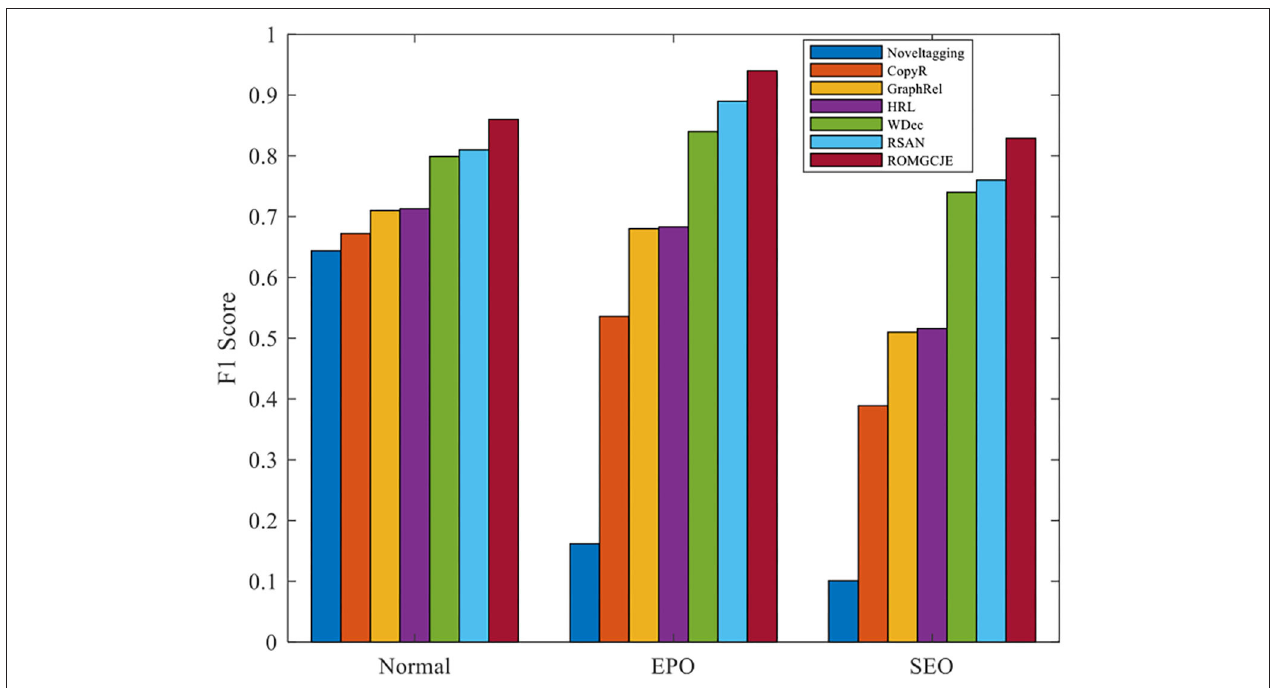
FIGURE 5 | Comparative experiments on normal, EPO, and SEO sentences.